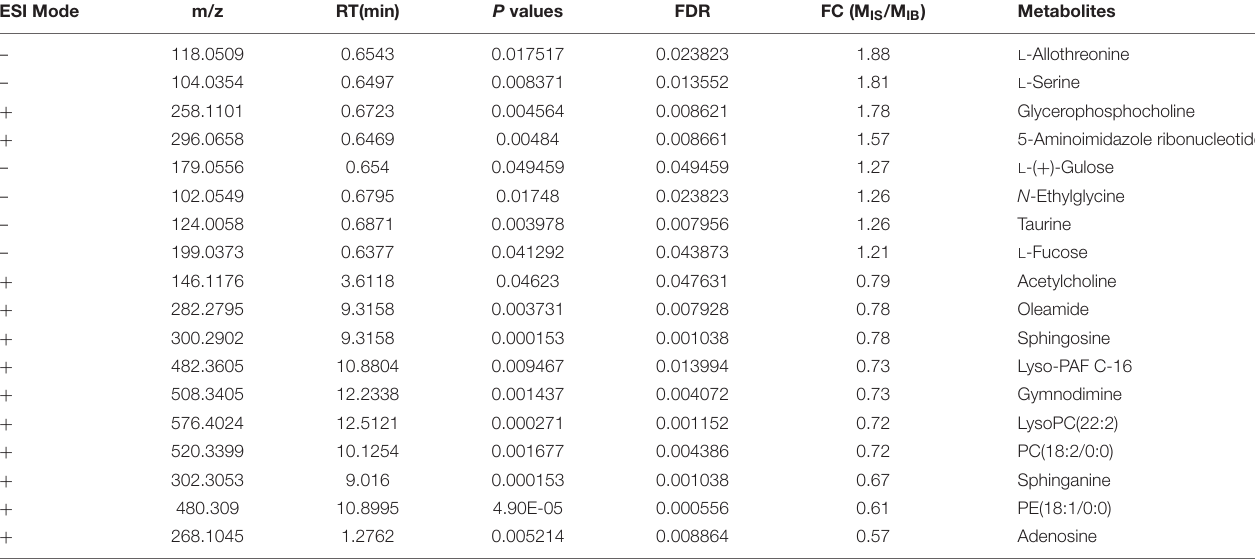
TABLE 2 | List of the male worm-specific differential metabolites between SCID mice and BALB/c mice. ESI Mode m/z RT(min) P values FDR FC (M IS /M IB )